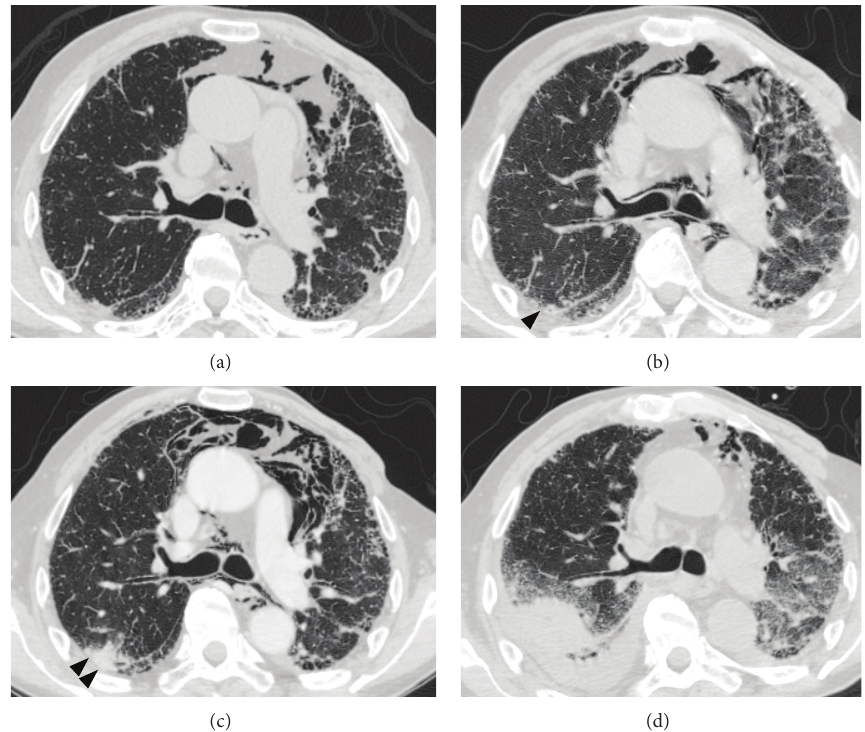
Figure 1: Serial changes in chest computed tomography findings. (a) Computed tomography (CT) scan taken 3 months before admission, showing reticular opacities and small cystic airspaces predominantly in subpleural regions. Mediastinal emphysema is also visible. (b) CT scan taken at admission, showing minimal mediastinal emphysema without major signs of pneumonia. Small centrilobular nodules are visible in the right upper lobe (arrowhead). (c) CT scan taken on the 20th day of hospitalization, showing consolidation in the right upper lobe (arrowheads). (d) CT scan taken on the 77th day of hospitalization, showing increased consolidation size with emergence of diffuse ground-glass opacities in both